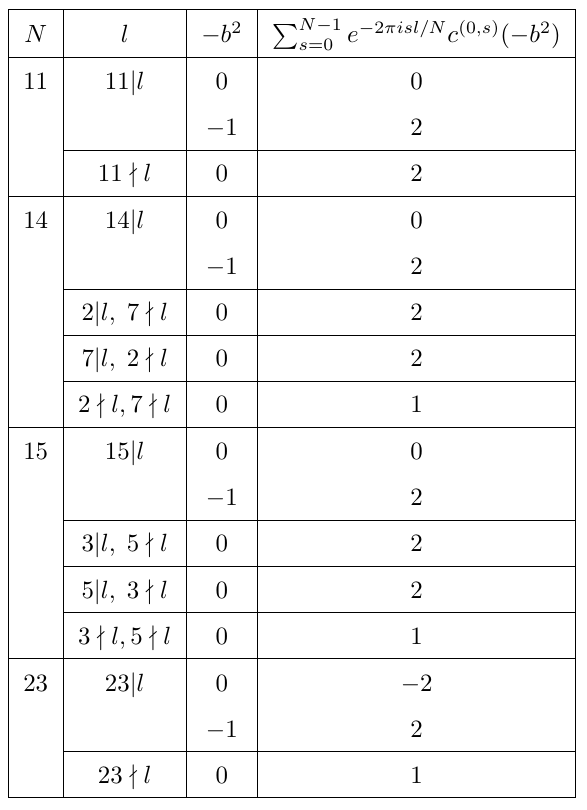
Table 3 . Values of P N − 1 e − 2 πisl/N c (0 ,s ) ( − b 2 ) for non-geometric orbifolds of K 3 where g 0 ∈ [ M 23 ] s =0